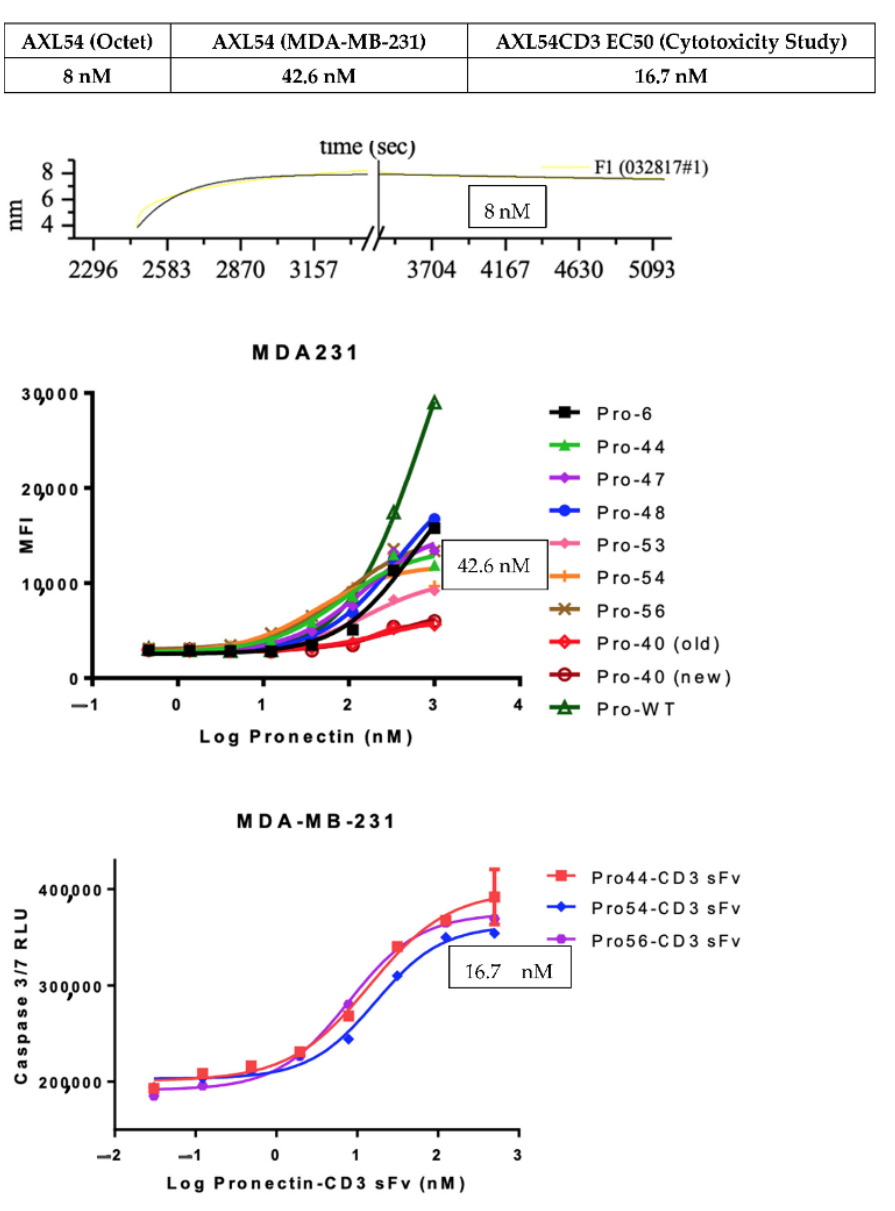
Figure 9. Summary of the Binding affinity of AXL54 Pronectin and the dose-dependent EC50 of the AXL54 on MDA-MB-231 cells and the EC50 of AXL54CD3 in the Cytotoxcity Assay.